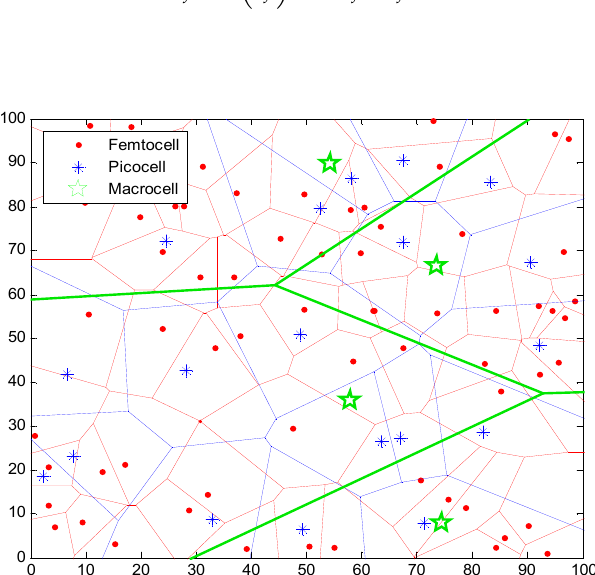
Figure 1. Base stations in multi-tier HetNets drawn from a PPP distribution include macrocells and different types of small cells, namely in this study, picocells and femtocells.